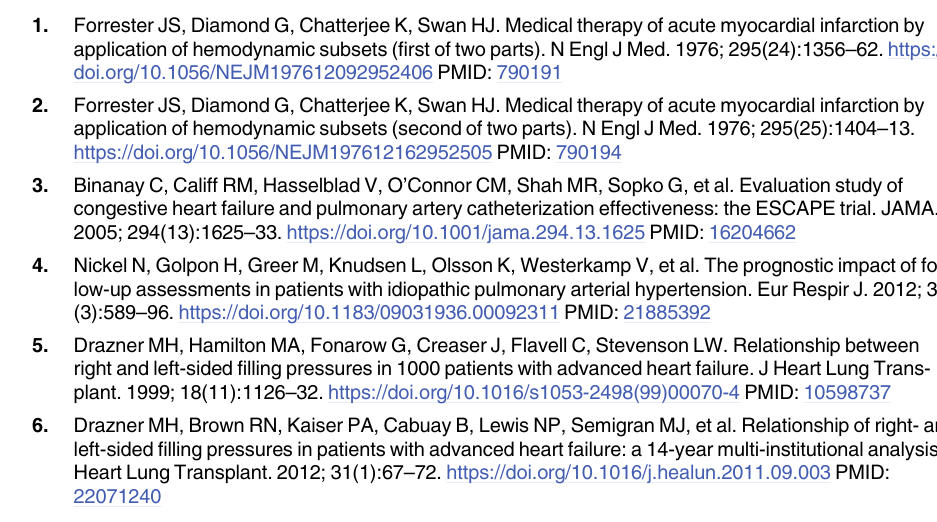
S1 Table. Multivariate Cox regression analysis predicting cardiac death. S2 Table. Multivariate Cox regression analysis predicting heart failure readmission. S1 Fig. Receiver operating characteristic curves of cardiac index and right atrial pressure for the primary endpoint. CI, cardiac index; RAP, right atrial pressure; AUC, area under the